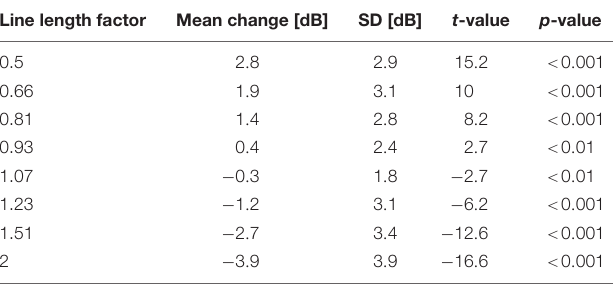
TABLE 2 | Adjustment in level to the offset of line length manipulations in the first column.